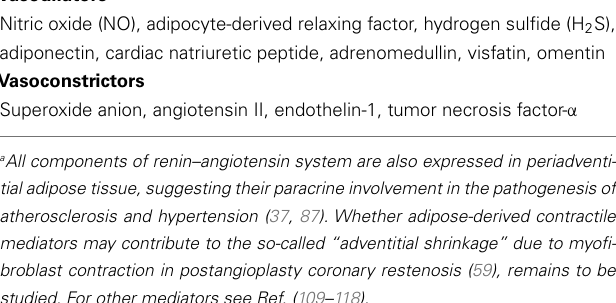
Table 3 |Adipose tissue-derived mediators controlling vascular tone a .